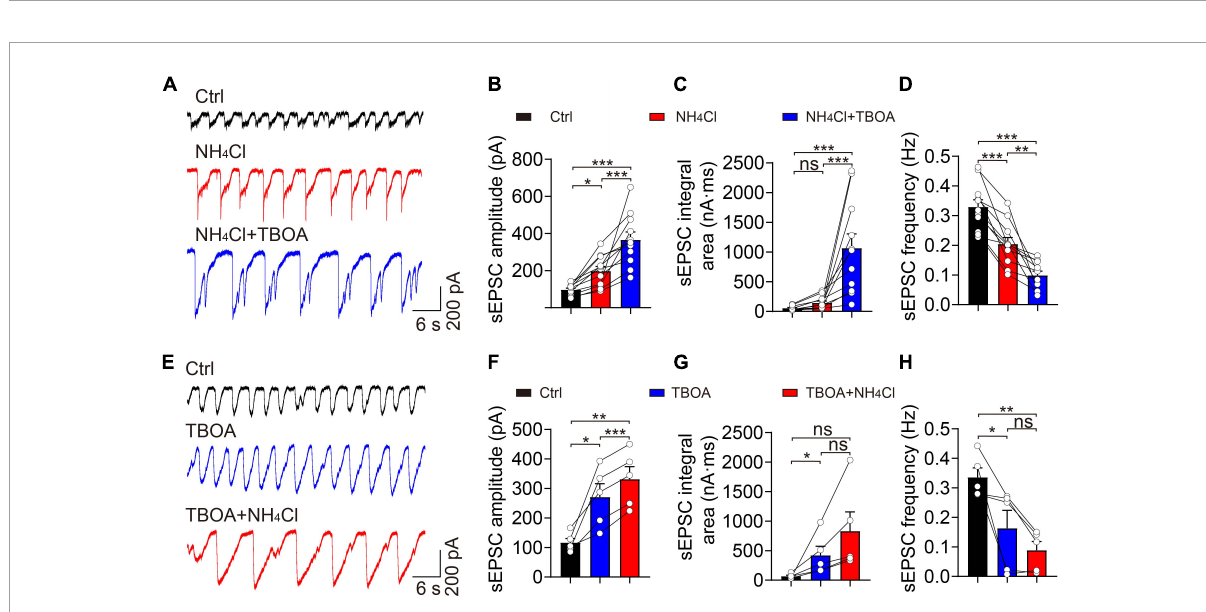
FIGURE5 Blockade of EAATs did not attenuate NH 4 + -induced potentiation of excitatory synaptic activity. (A) Representative traces showing sEPSCs recorded in a voltage-clamp configuration in the presence of Bic + Stry, showing the changes in sEPSC amplitude and integral area in Ctrl, NH 4 Cl, and NH 4 Cl + TBOA (30 µ M), respectively. (B–D) sEPSC amplitude, integral area, and frequency in sequential treatments with Ctrl, NH 4 Cl, and NH 4 Cl + TBOA. (E) Typical sEPSC traces from a MC in sequential treatments of Ctrl, TBOA, and TBOA + NH 4 Cl. (F–H) Post hoc analysis of sEPSC amplitude, integral area, and frequency in Ctrl, TBOA, and TBOA + NH4Cl, respectively. Error bars represent standard error; * p < 0.05, ** p < 0.01, *** p < 0.001; ns, not significant; one-way ANOVA with LSD post-hoc